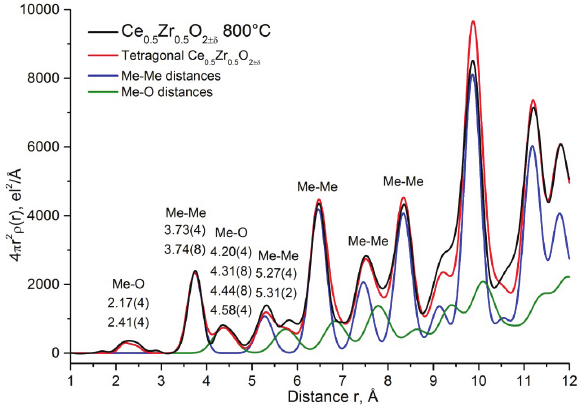
Figure 4: The pair distribution function (PDF) curve calculated from total X-ray scattering data for sample Ce curves.